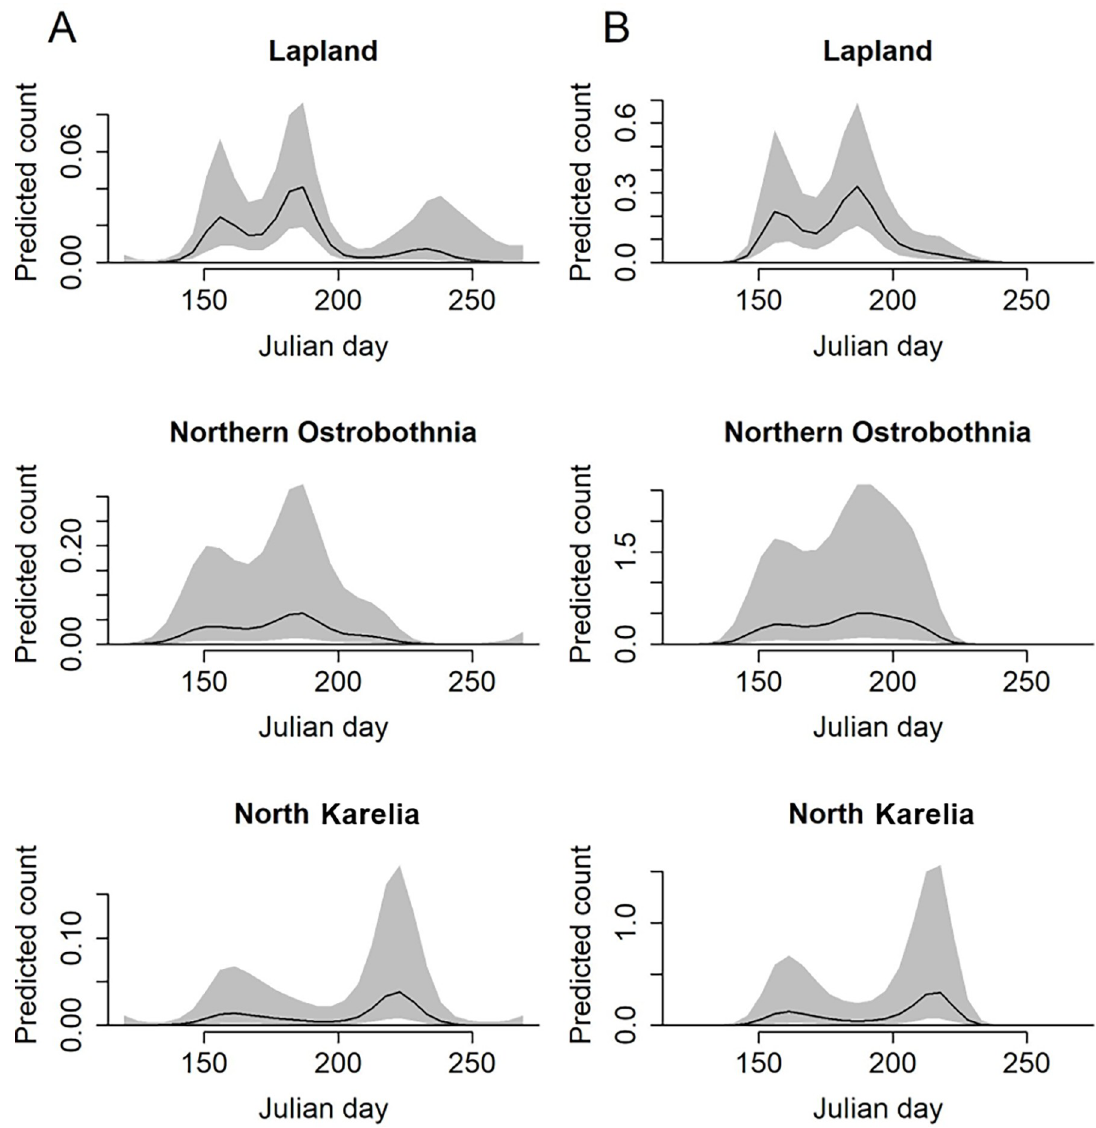
Fig 2. Seasonal variation in taiga bean goose count. Model predicted count (per unit effort) of taiga bean geese (mean with 95% prediction interval) with Julian day for the years a) 2018 and b)